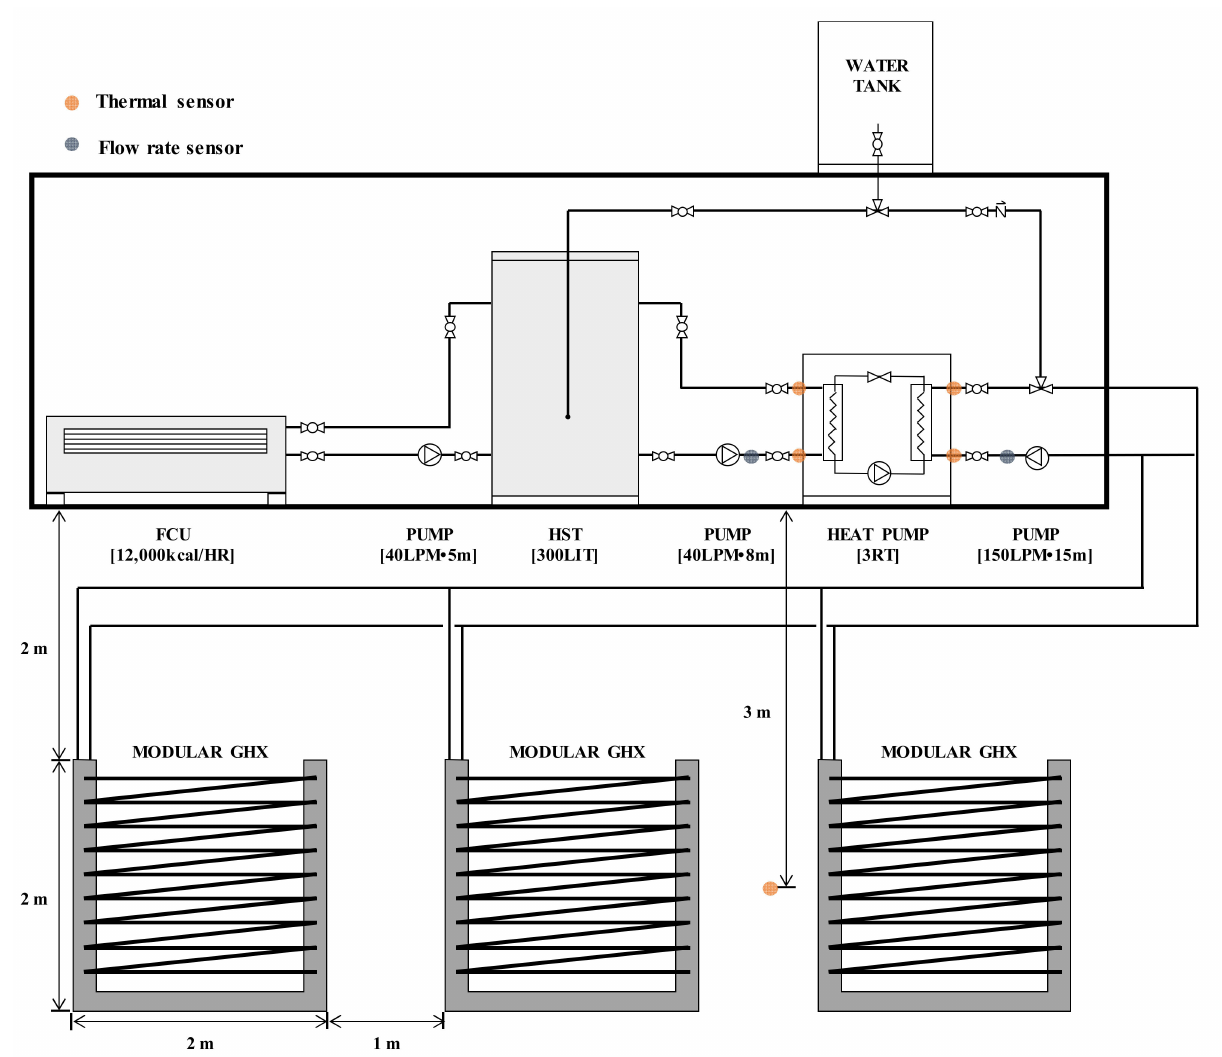
Figure 7. Diagram of modular GHX with locations of thermal and flow rate sensors